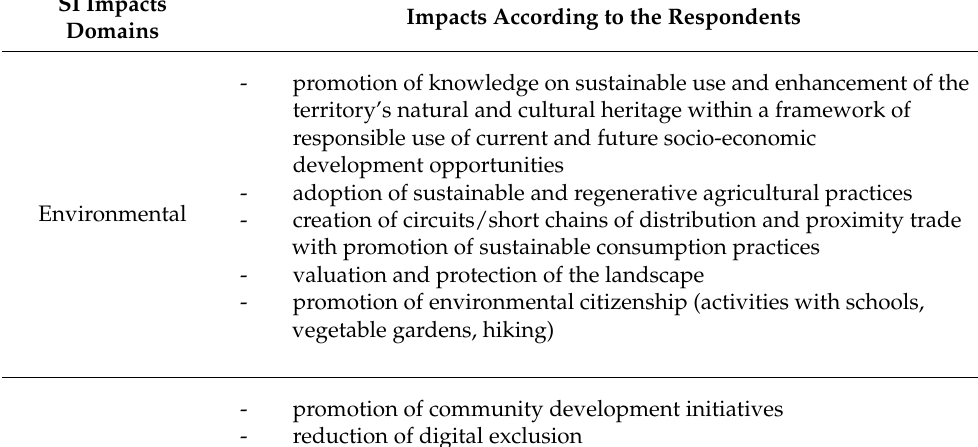
Table 4. SI impacts in four domains according to the respondents. Source: author’s own